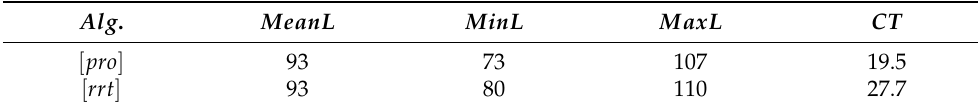
Table 1. MATLAB simulation results (scenario